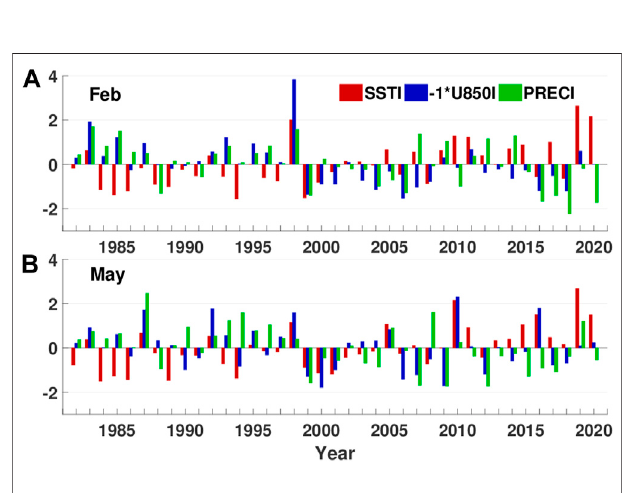
FIGURE 14 | Interannual variability of the CFSv2-predicted July SSTI (redbars) , − U850I (bluebars) ,andPRECI (greenbars) ,at (A) 4- (February) and (B) 2-months (May)